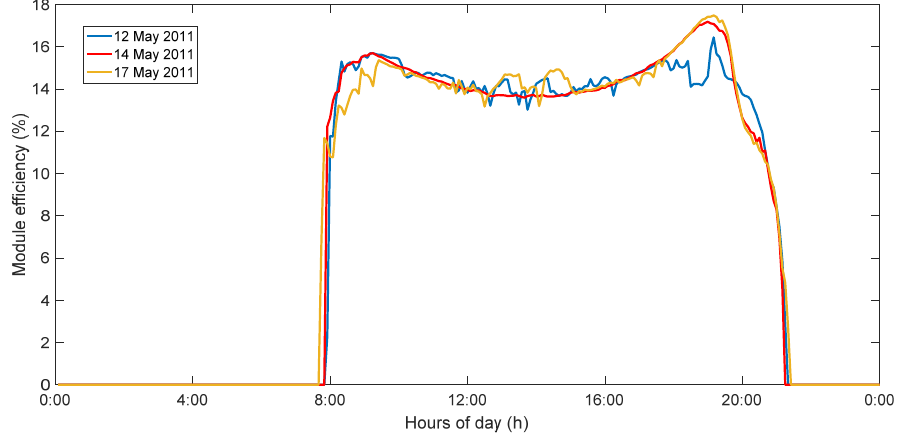
Figure 20. Daily profiles of module efficiency obtained during 12, 14 and 17 May 2011.